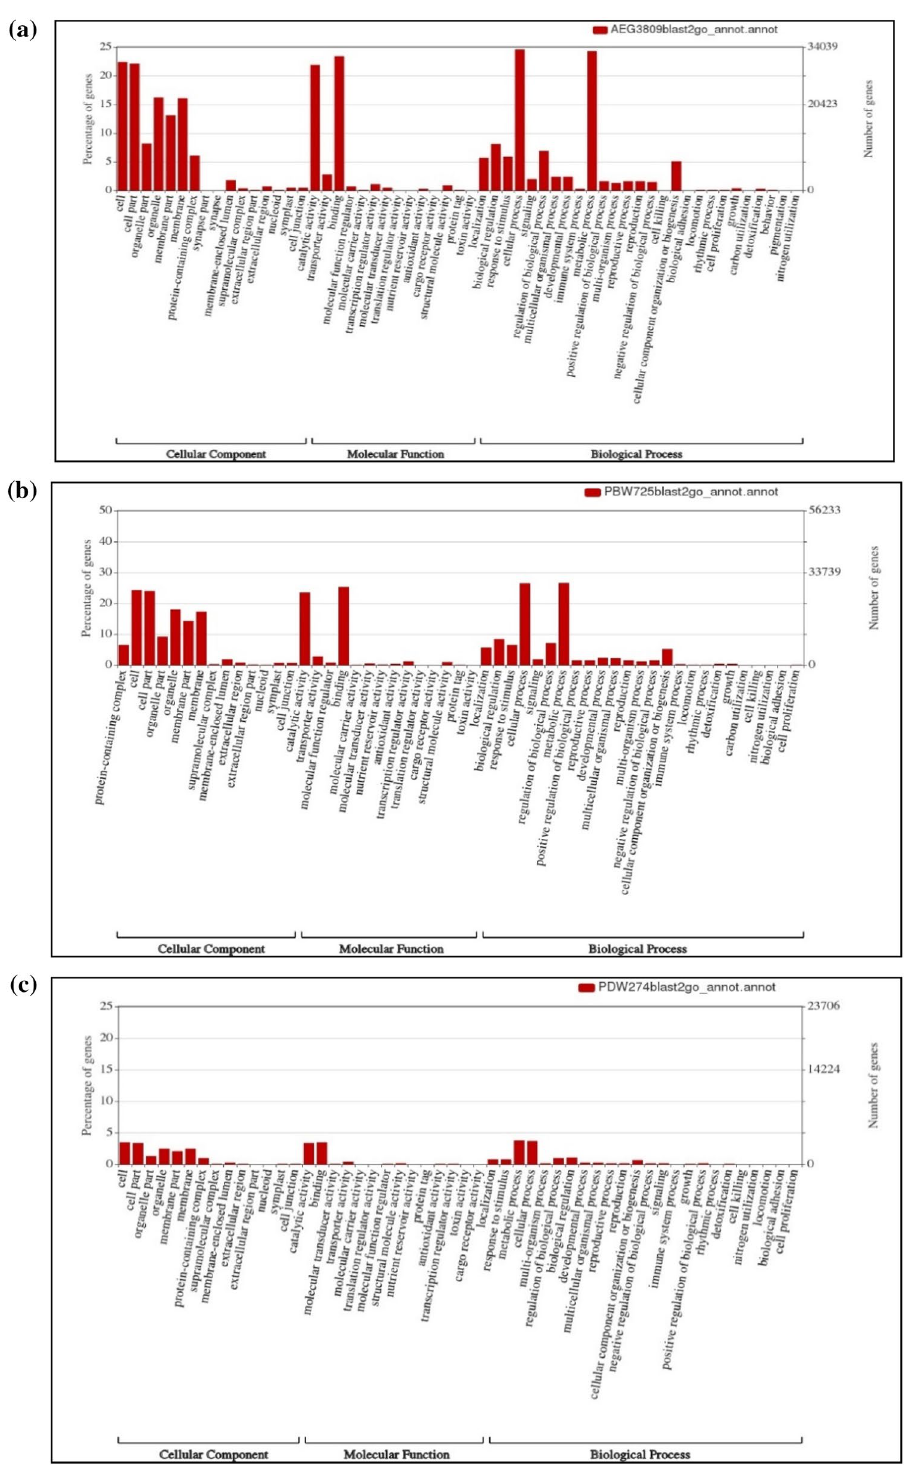
Figure 1. Proportion of gene ontology annotations made using WEGO for transcripts of ( a ) Aegilops speltoides acc. pau3809, ( b ) T. aestivum cv. PBW725 and ( c ) T. durum cv. PDW274 representing a cellular component, molecular function, and biological